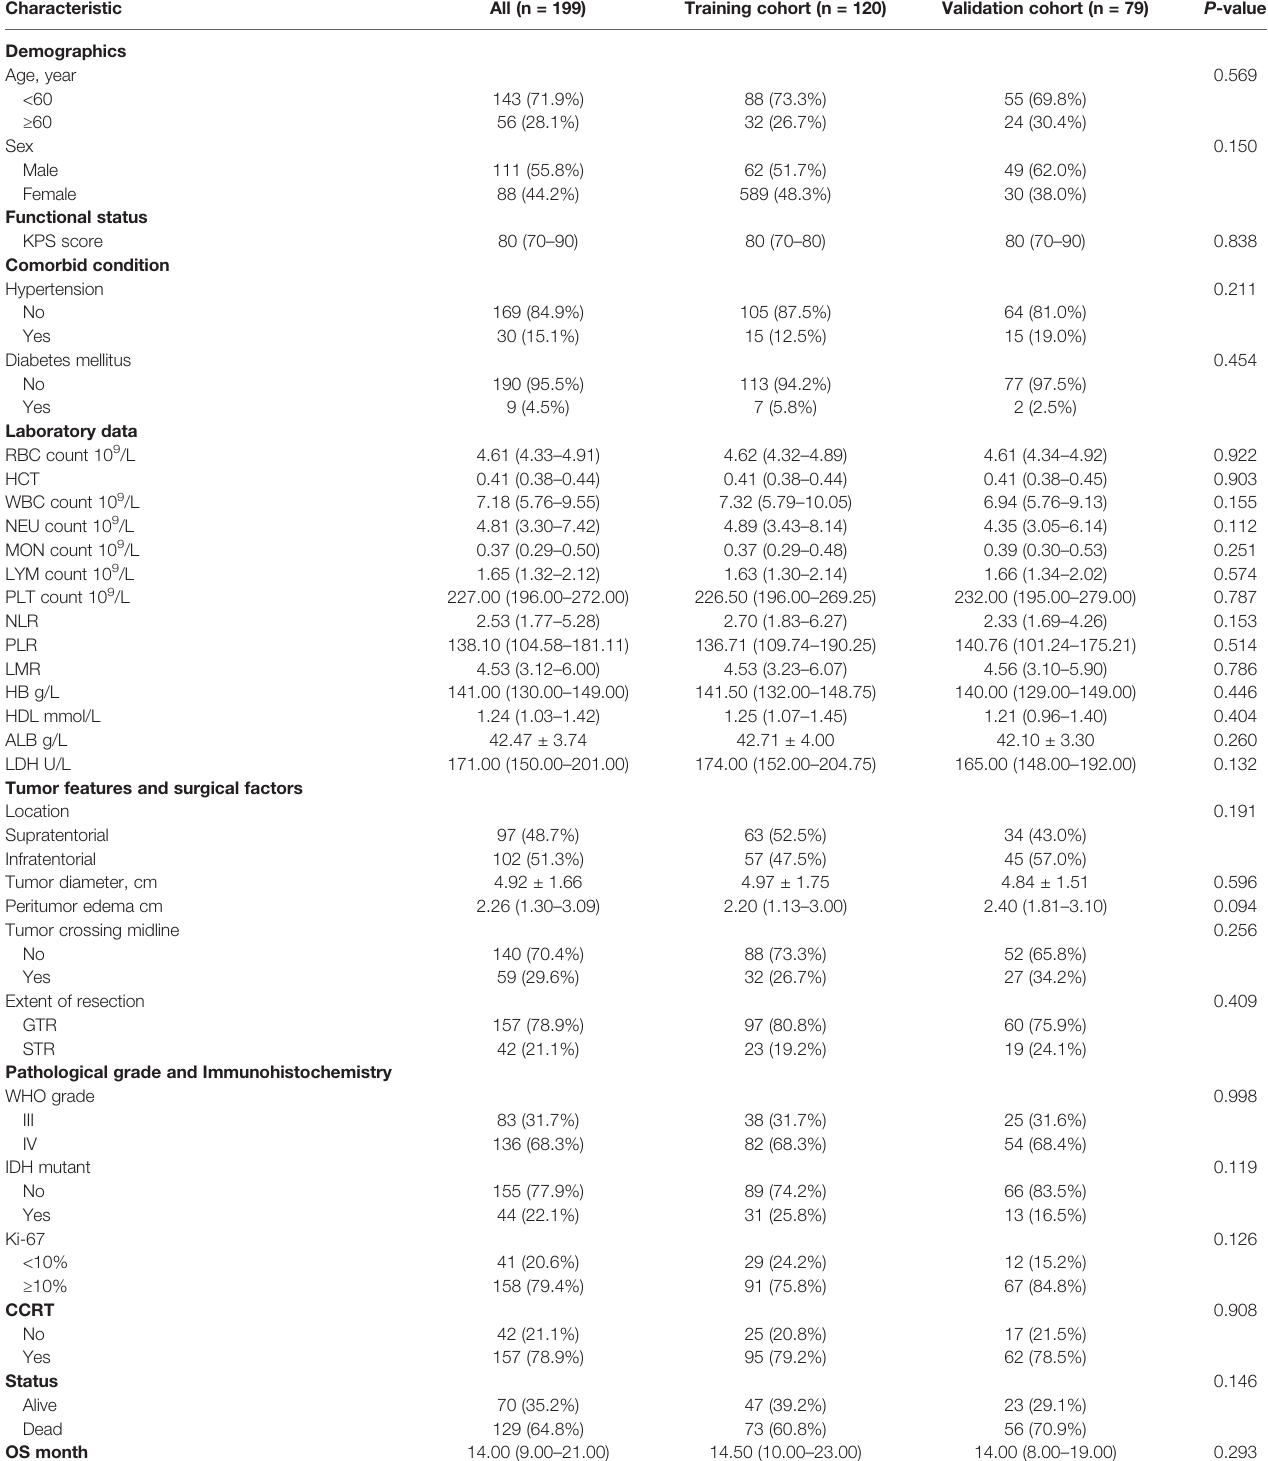
TABLE 1 | Characteristics of patients in the training and validation